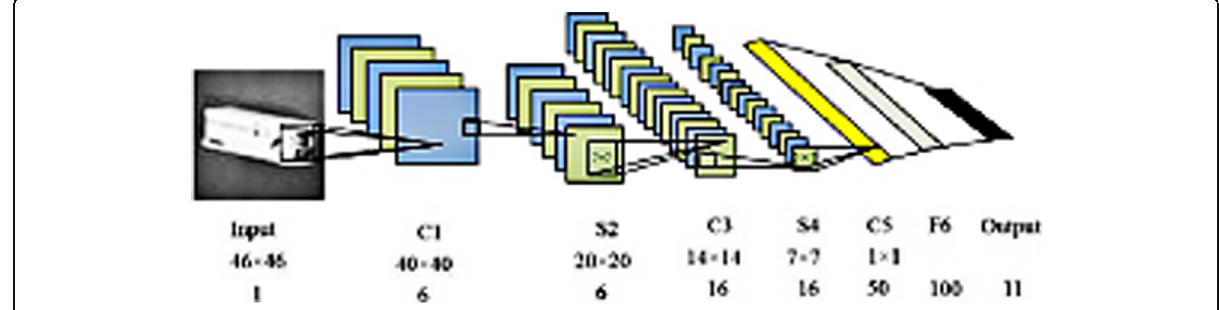
Fig. 5 Convolution neural network structure